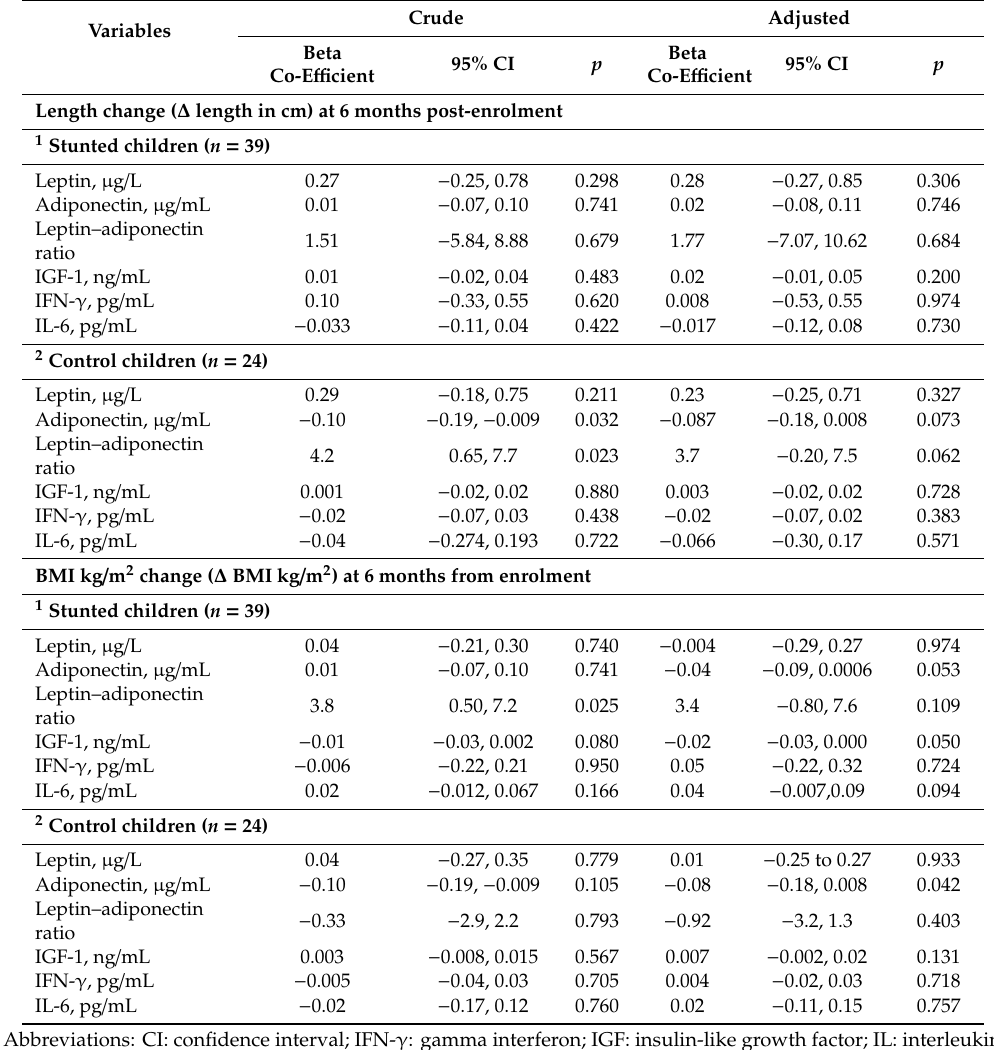
Table 5. Association of child length and BMI change with adipokines and peptides at six months post-enrollment among stunted and control